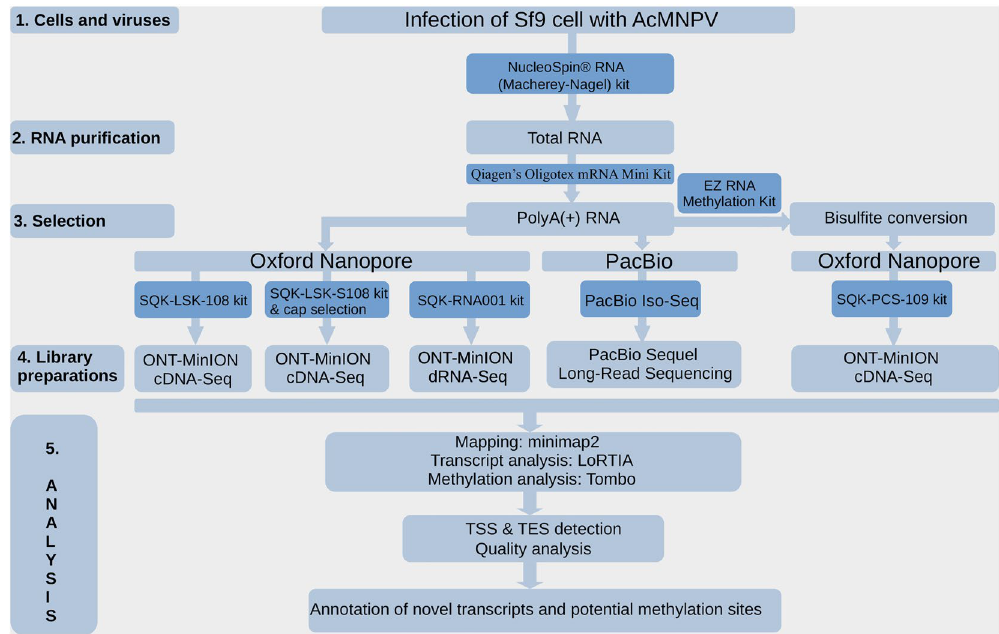
Figure 1. Workflow of transcriptome and epitranscriptome analyses. The types of kits used for each workflow are shown in the dark blue boxes. Spodoptera frugiperda cells were infected with Autographa californica nuclear polyhedrosis virus (AcMNPV). RNA was isolated from the infected cells, and after poly (A) selection, the samples were sequenced using the Oxford Nanopore technologies (ONT) and the Pacific Biosciences (PacBio) Sequel platforms. In the case of ONT, we used PCR-amplified cDNA-seq (SQK-LSK-108, SQK-PCS-109 kit) and dRNA-seq (SQK-RNA001 kit). ONT dRNA-seq was also applied to determine possible methylation sites using the Tombo software. To confirm the methylation sites, bisulfite conversion was also performed using ONT sequencing. The base-called sequences were aligned with the reference genome using the minimap2 long-read mapping software, followed by the determination of TSS and TES positions of each transcript using the LoRTIA program. The illustration was created with Microsoft PowerPoint 2021 software 47 .